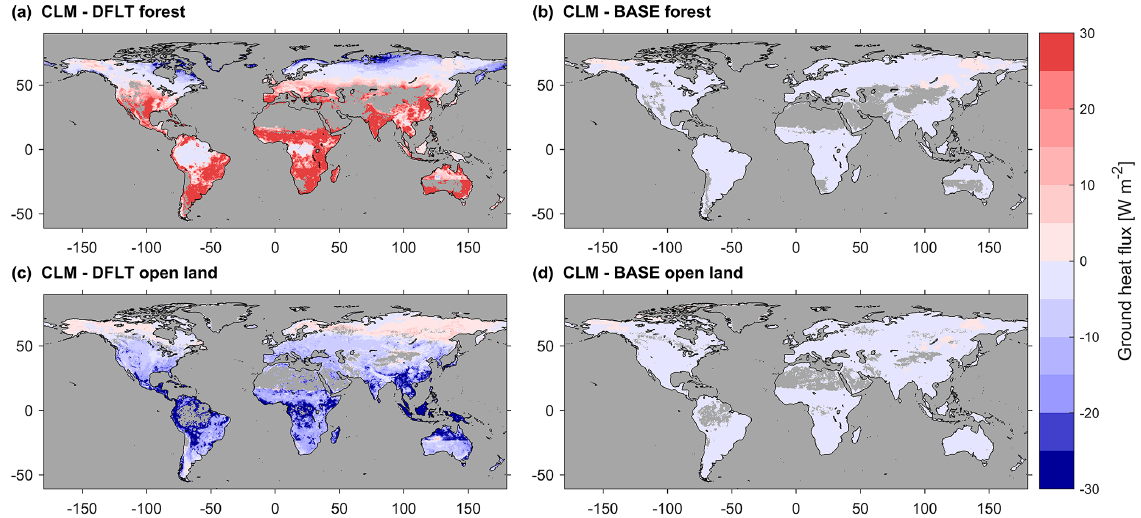
Figure A2. GHF for forests (a, b) and open land (c, d) in CLM-DFLT (a, c) and CLM-BASE (b, d) . Positive values correspond to a heat flux out of the soil.